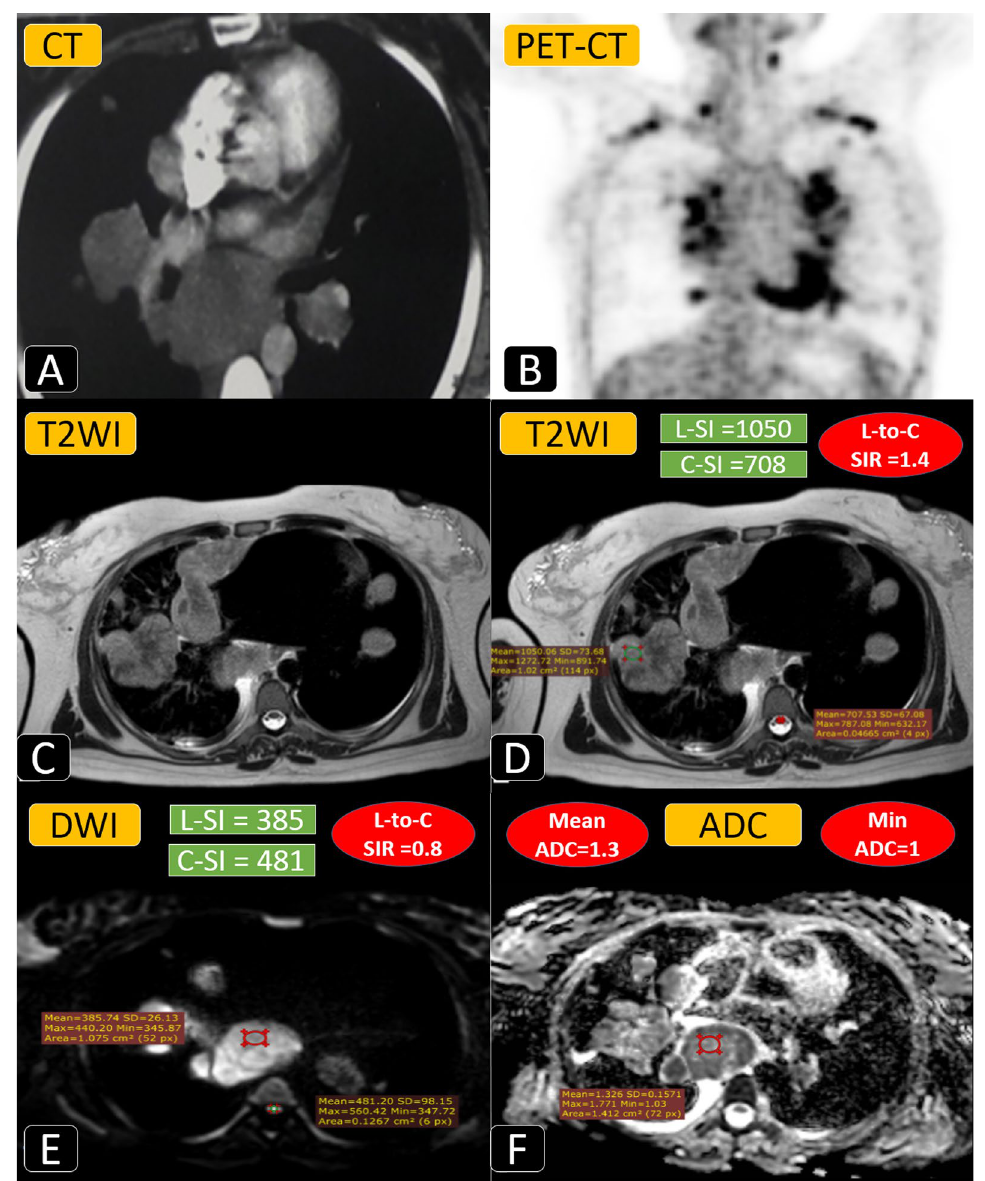
Fig. 3 A 24-year-old female patient complained of chronic cough and dyspnea. A Axial contrast-enhanced chest CT cut (mediastinal window) showed bilateral hilar and posterior mediastinal sub-carinal nodal enlargement. B Coronal chest PET-CT image showing high 18F-FDG uptake at thoracic, bilateral supra-clavicular, and left cervical nodal enlargement. C, D Axial T2WI showing the high signal intensity of bilateral nodal and parenchymal masses. After placing two ROIs within the largest lesion and the spinal cord, the lesion-to-spinal cord signal intensity ratio was calculated 1.4. E Axial DWI showing bright signal of restricted diffusion and lesion-to-spinal cord signal intensity ratio was calculated = mapping images showing low signal intensity with minimum ADC (1 cell